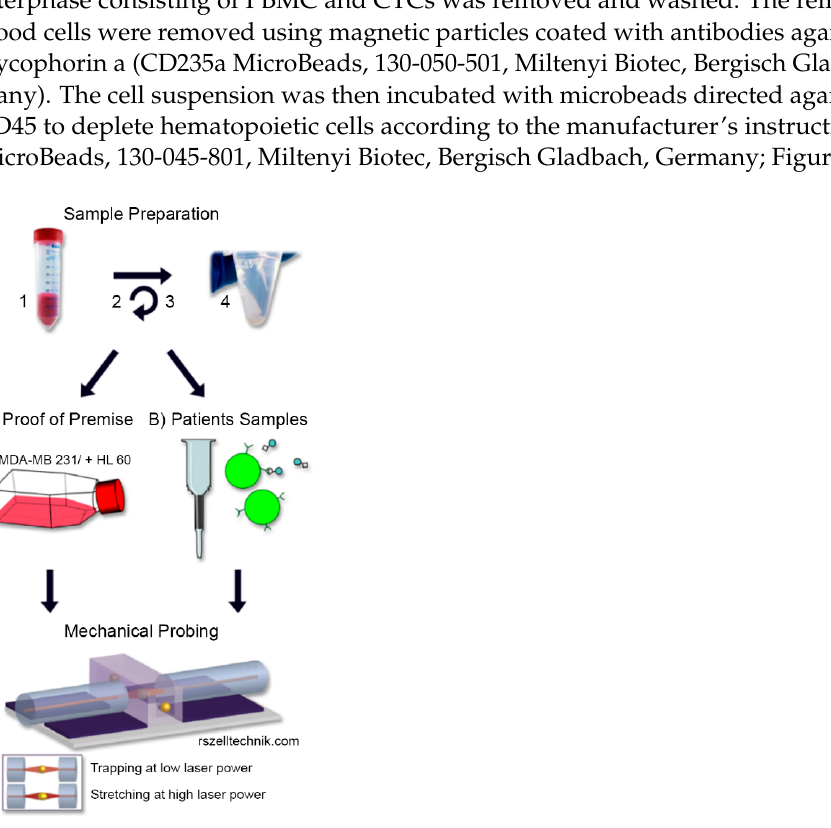
Figure 1. Sample preparation and measurement: 1. Whole blood sample diluted with PBS; 2. density gradient centrifugation; 3. depletion of red blood cells using microbeads against glycophorin a and 4. resulting PBMC were resuspended and ( A ) spiked with MDA-MB 231 breast cancer cells and HL-60 leukemia cells for proof of premise experiments to mimic CTC samples or ( B ) incubated with microbeads against CD45 to deplete hematopoietic cells and thus enrich possible CTC candidates from clinical samples. Spiked respective remaining cell suspensions were applied to the optical stretcher and rheological parameters were measured.